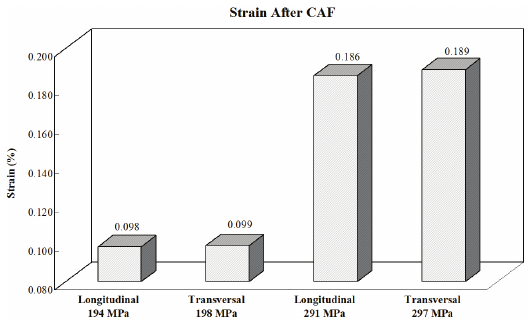
Figure 13. Residual strain after